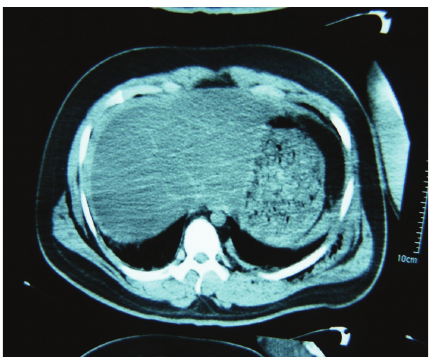
Figure 3: Abdomen CT image of the